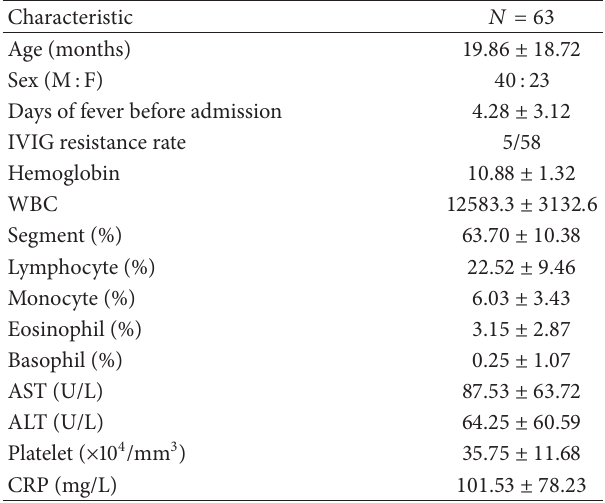
Table 1: Demographic and clinical characteristics of patients with Kawasaki